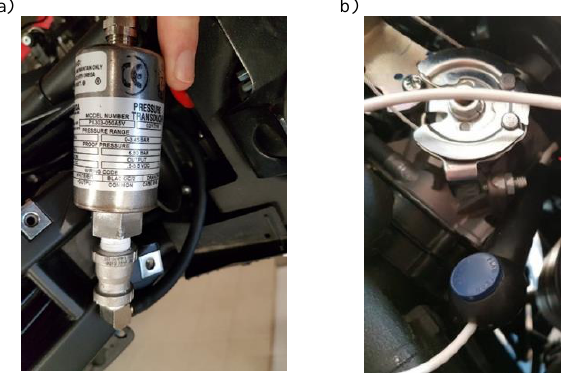
Fig. 4. Tooling for the intake manifold: a) vacuum transducer, b) tempera- ture probe